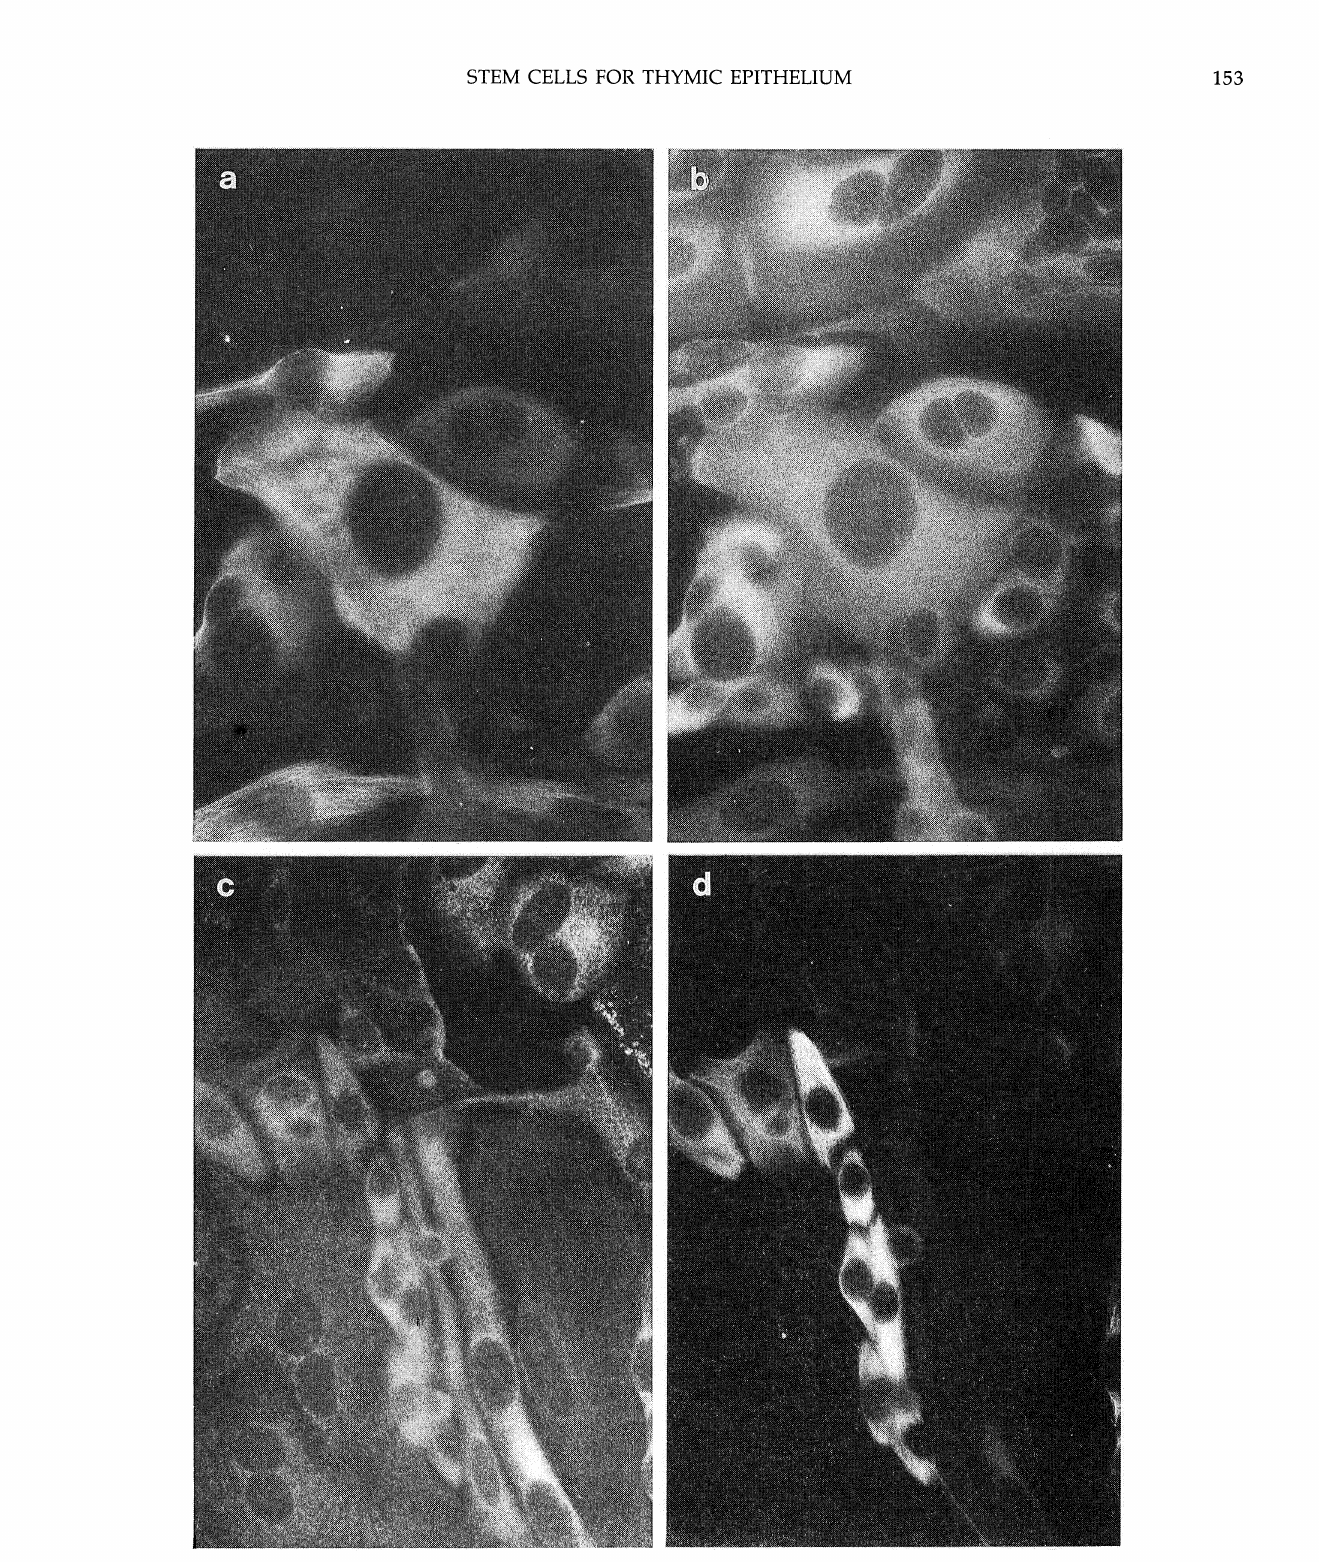
FIGURE 4. Photomicrographs of double-stained cultured murine thymic epithelial cells. Cells were labeled with either biotinylated ER-TR4 + avidin-Texas red (Tex) and ER-TR5 + RaRA-FITC or biotinylated ER-TR5 + avidin-Texas red and ER-TR4 + RaRA-FITC, and photos were taken of the same cells (a and b, or c and d) by alternative use of red and green optic filters (a) TR4-FITC, (b) TR5-Tex (x 916), (c) TR4-Tex, and (d) TR5-FITC (x